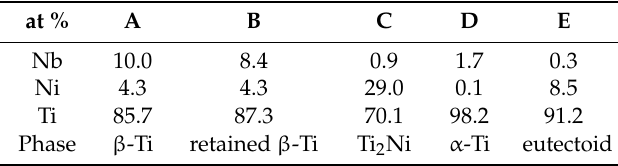
Figure 3. EPMA BEIs of CP-Ti/40Ti-35Ni-25Nb/CP-Ti joint brazed at 1000 °C for 600 s: ( a ) cross section overview, ( b ) higher magnification of location I in ( a ). Table 1. EPMA quantitative chemical analysis results in Figure 3.